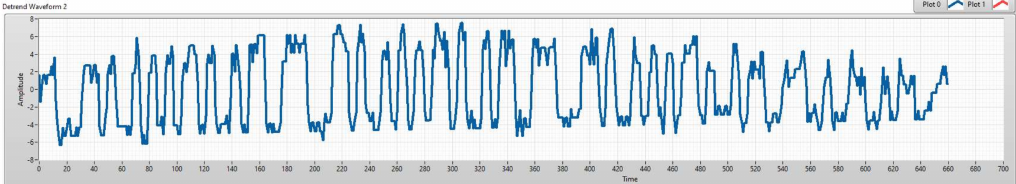
Figure 2. An experimental result of COOK signals within a rolling image with low signal-to-noise ratio